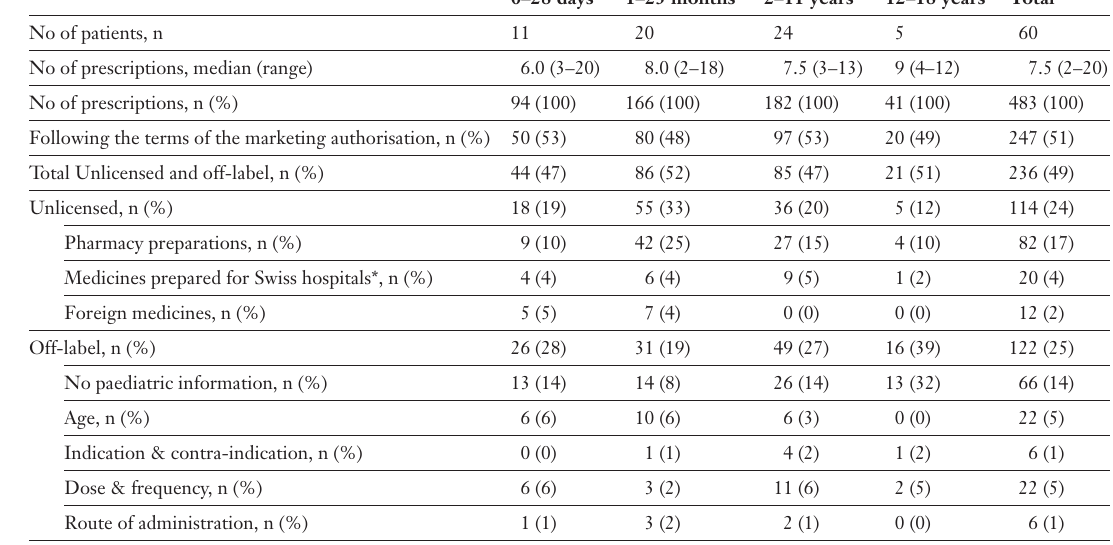
Unlicensed and off- label prescriptions according to age.